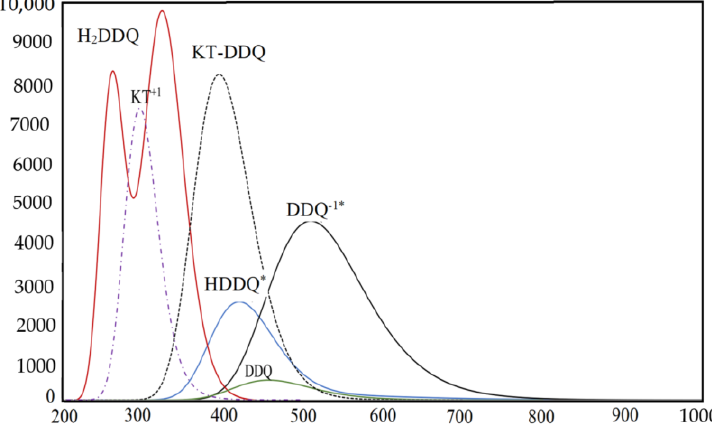
Figure 7. The electronic absorption spectra of the donor (KT) and acceptor DDQ as well as their probability ions (DDQ −1 ·, HDDQ·, and H2DDQ) and CT complex (KT–DDQ) in ACN at 298 K.